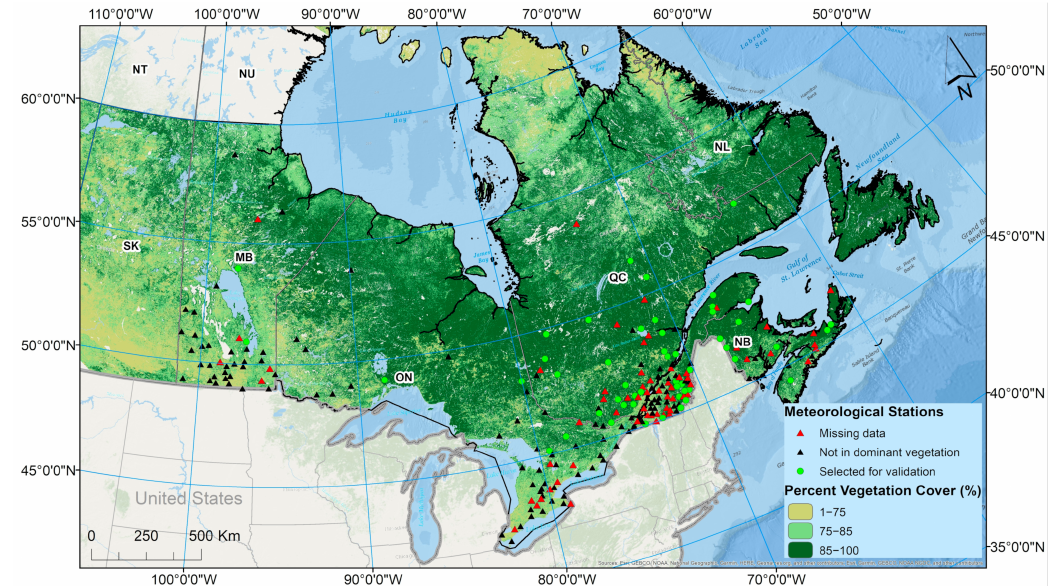
Figure 2. Meteorological stations used for validation were located in a 3 km buffer area with an average percent vegetation cover greater than 85% and covered more than fifty percent (50%) by forest.